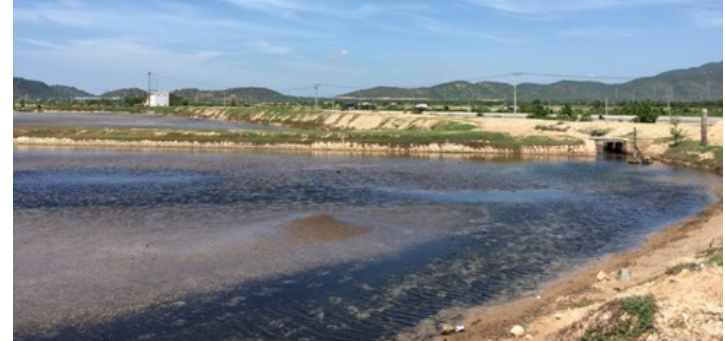
Figure 11. Salt production in Phuoc The